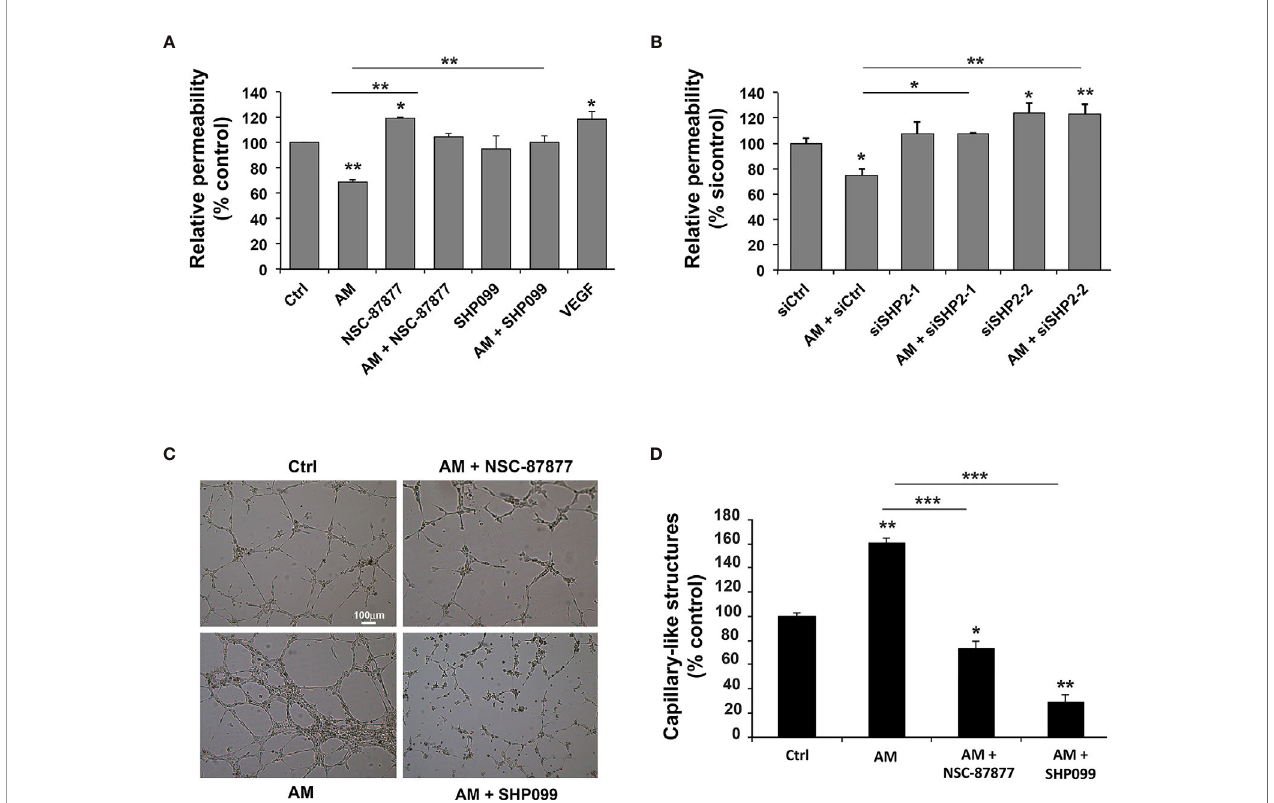
FIGURE 5 | Inhibition of SHP-2 impairs AM-induced decreases of HUVECs permeability and AM ability to form capillary-like structures in vitro . (A) Paracellular permeability for 250 KDa FITC-dextran was determined for HUVECs, treated either with AM (10 -9 M), or AM (10 -9 M) in presence of NSC-87877 (30 m M), or SHP099 (30 m M), and cultured on Transwell fi lters. Permeability of control cells was set to 100% (n = 6 for each group). **, p < 0.01. (B) HUVECs were transfected with control siRNA (siCtrl) or with siRNAs directed against SHP-2 and cultured on Transwell fi lters for 24 h. Paracellular permeability for 250 kD FITC-dextran was determined. Permeability of control-transfected cells was set to 100% (n = 4 for each group). (C) The morphogenic activity of AM is impaired upon inhibition of SHP- 2. HUVECs (7 x 10 4 cells/well) were seeded into Matrigel-precoated wells and cultured in low-serum conditions (0.5% FBS) in absence (Ctrl) or presence of AM (10 -9 M), AM (10 -9 M) + NSC-87877 (30 m M), AM (10 -9 M) + SHP099 (30 m M). (D) Photographs were taken to cover the whole surface after treatment for 5 h, and capillary-like structures were quanti fi ed. Scale bar, 100 m m; * p < 0.05; ** p < 0.01; *** p < 0.001. The value of control cells was set to 100%. Each experiment is representative of three (A, B) , and four (D) independent experiments. Results are shown as means ±